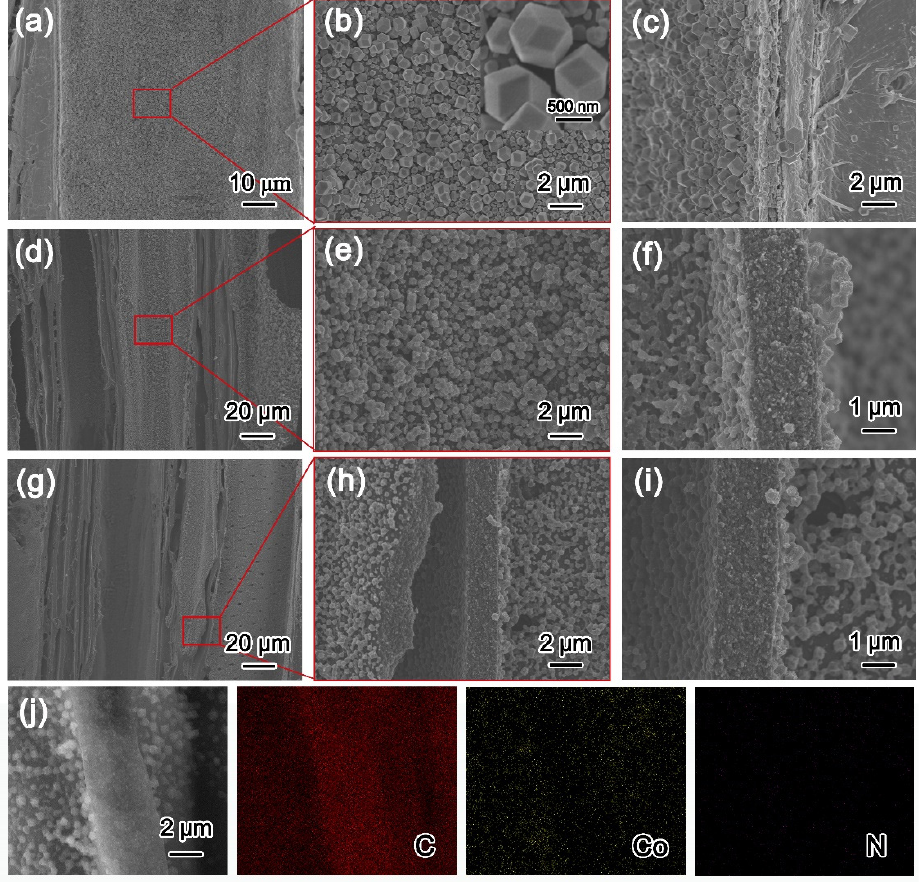
Figure 2. SEM images of HZ@Wood ( a – c ), Zn-Co@CW ( d – f ), and Zn-Co 3 O 4 @CW-230 ( g – i ); C, Co, Zn mapping of Zn-Co 3 O 4 @CW-230 ( j ).